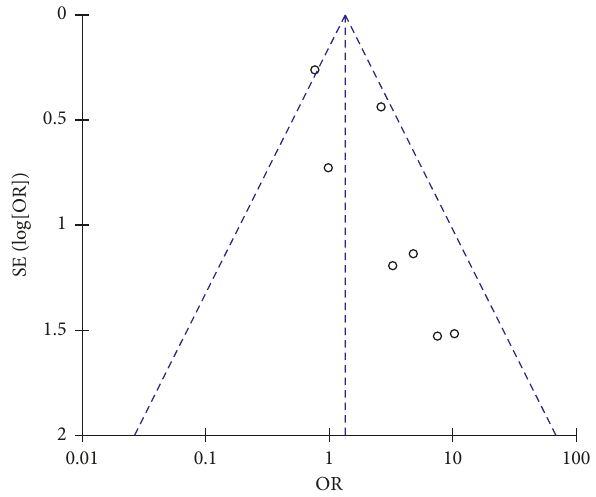
Figure 4: Funnel plot for overall postoperative complication rate.